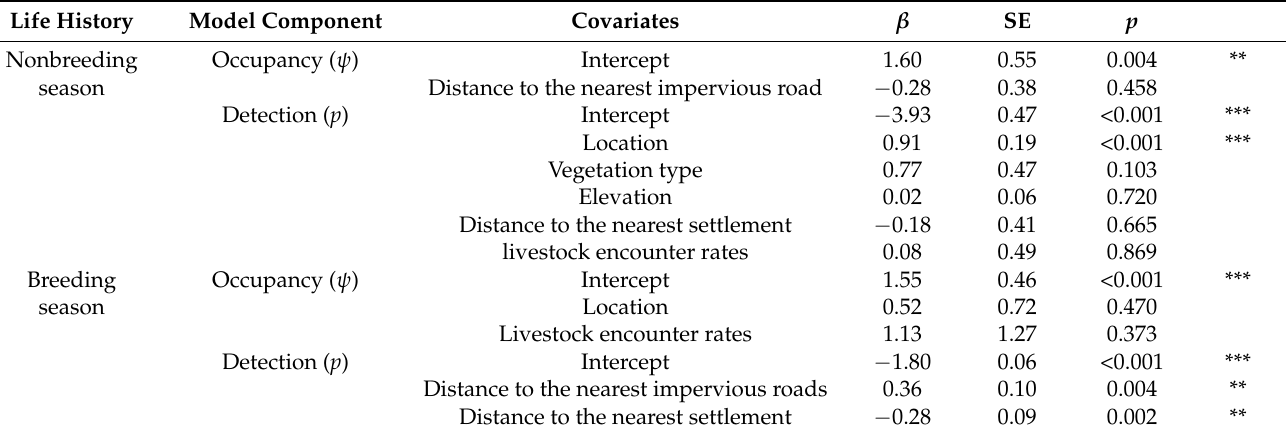
Table 2. Effect of β -coefficients and standard errors (SE) based on model averaging to assess occu- pancy and detectability of Reeves’s